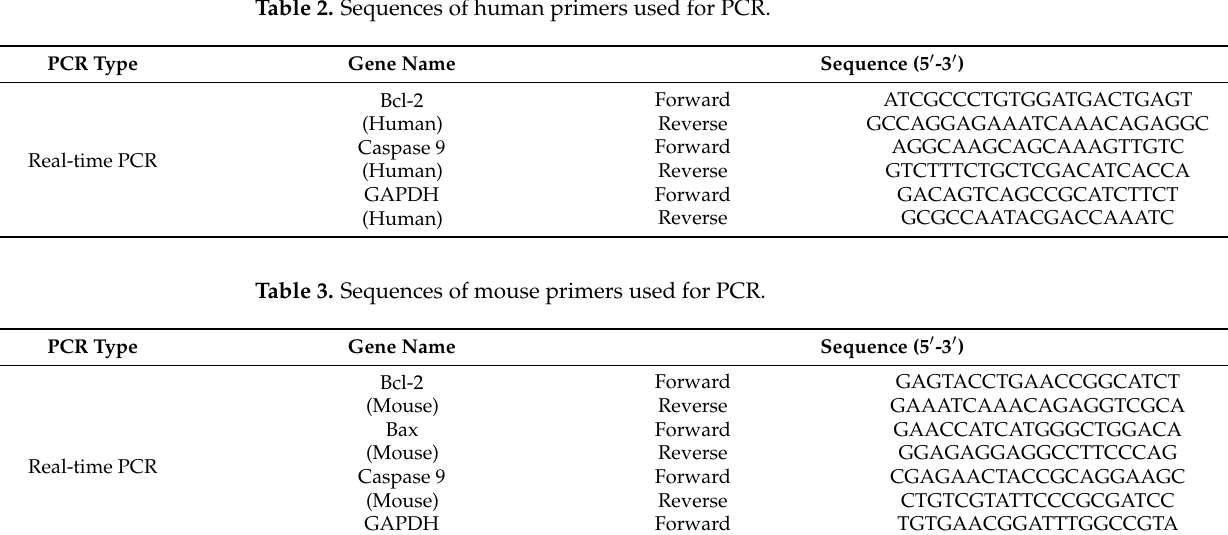
Table 2. Sequences of human primers used for PCR.